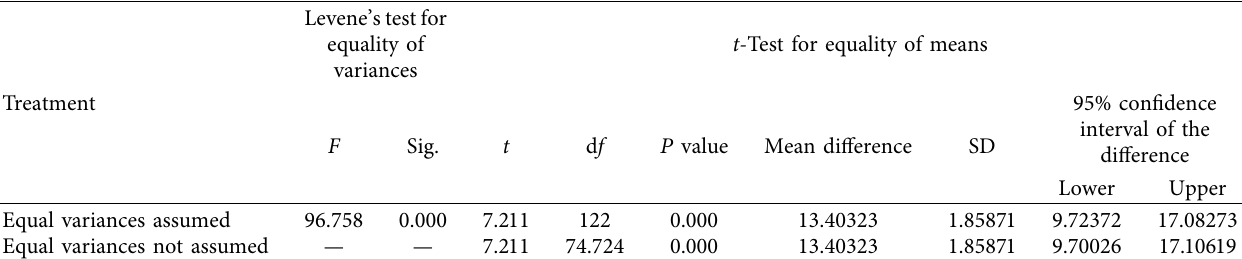
Table 16: SPSS software outputs regarding the different tests of the average amount of overproduction. Response Year Amount of additional production (MWh)